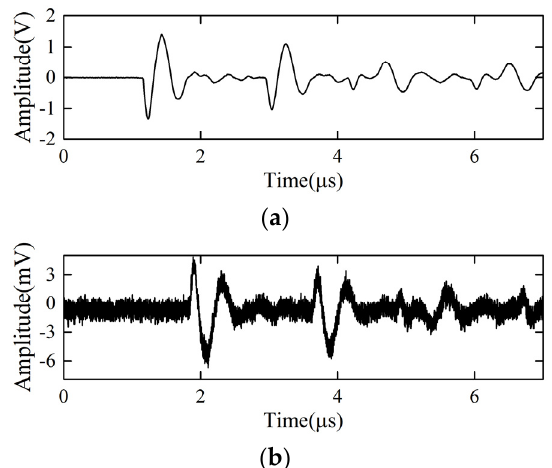
Figure 15. Measured PD waveforms of defective cables. ( a ) The electrical tapes are used for the semi-conductive tapes by mistake; ( b ) The metal tips are not polished.